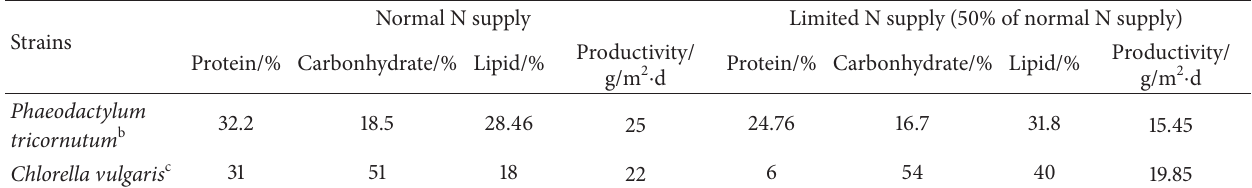
Table 1: Productivity and cell composition of algae grown under N-sufficient and N-limited conditions.